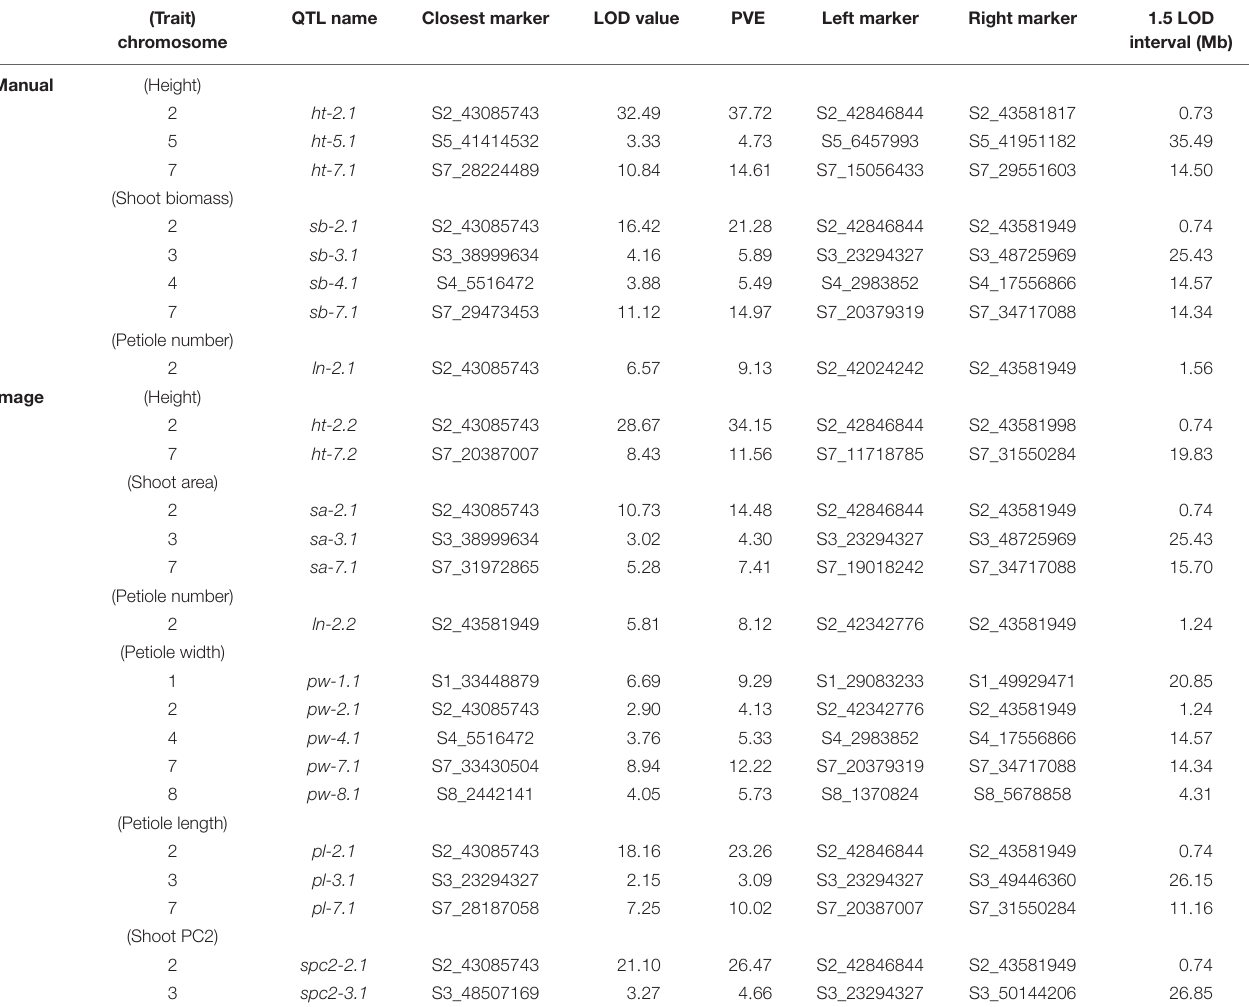
TABLE 3 | Significant QTL ( α = 0.05), LOD values, percent variance explained (PVE), and 1.5 LOD intervals for manual and image-based measurements of shoot traits in